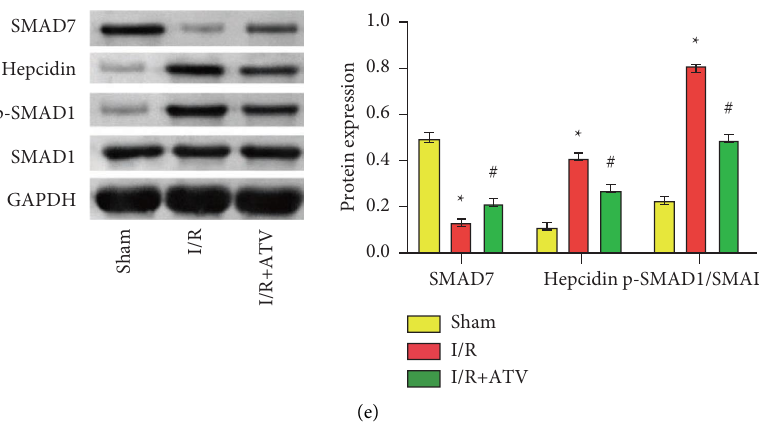
Figure 5: ATV improved ferroptosis in I/R rat myocardium by the SMAD7/hepcidin pathway. (a) Cardiac histopathology was observed by HE staining (100 × and 400 × ). (b) Te levels of Fe 2+ and total iron were detected by ELISA. (c) Te expression of IRPs, TFRC1, FTH, and FPN1 was detected by qPCR. (d–e) Te expression of ACSL4, GPX4, SMAD7, SMAD1, p-SMAD1, and hepcidin proteins was detected by Western blot. ∗ P < 0 . 05 vs. the sham group; # P < 0 . 05 vs. the I/R